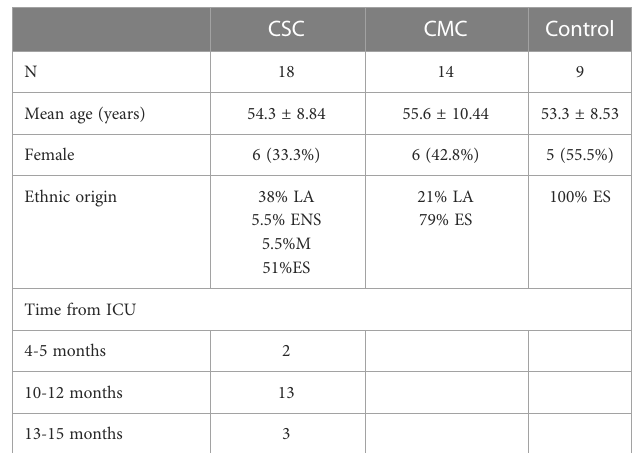
TABLE 1 Characteristics of the groups included in the